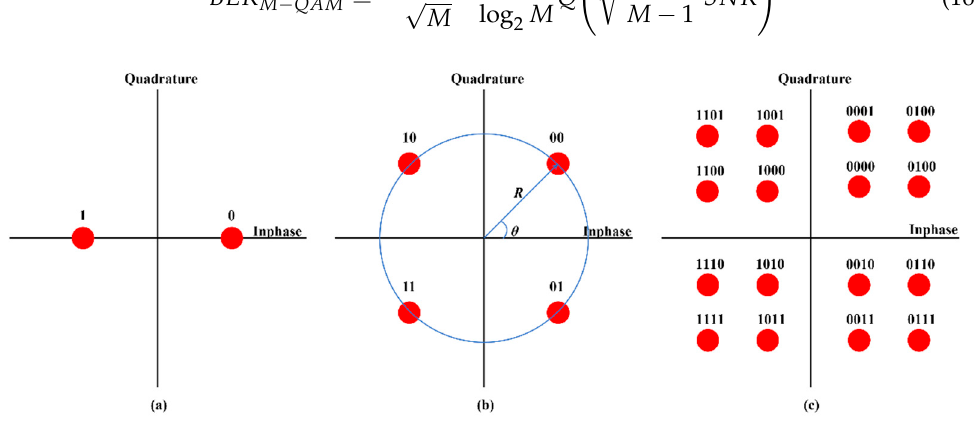
Figure 11. Constellation diagram of ( a ) BPSK, ( b ) 4-QAM (QPSK) and ( c ) 16-QAM.